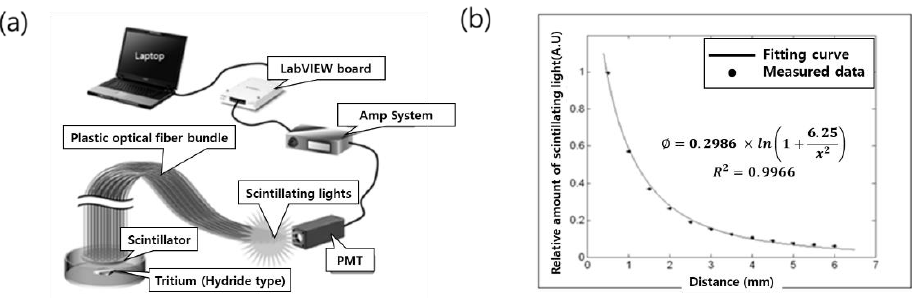
Figure 4. Configuration of the optical fiber-based sensor for detecting tritium ( a ) and the relative amount of scintillation ( b ) [30].